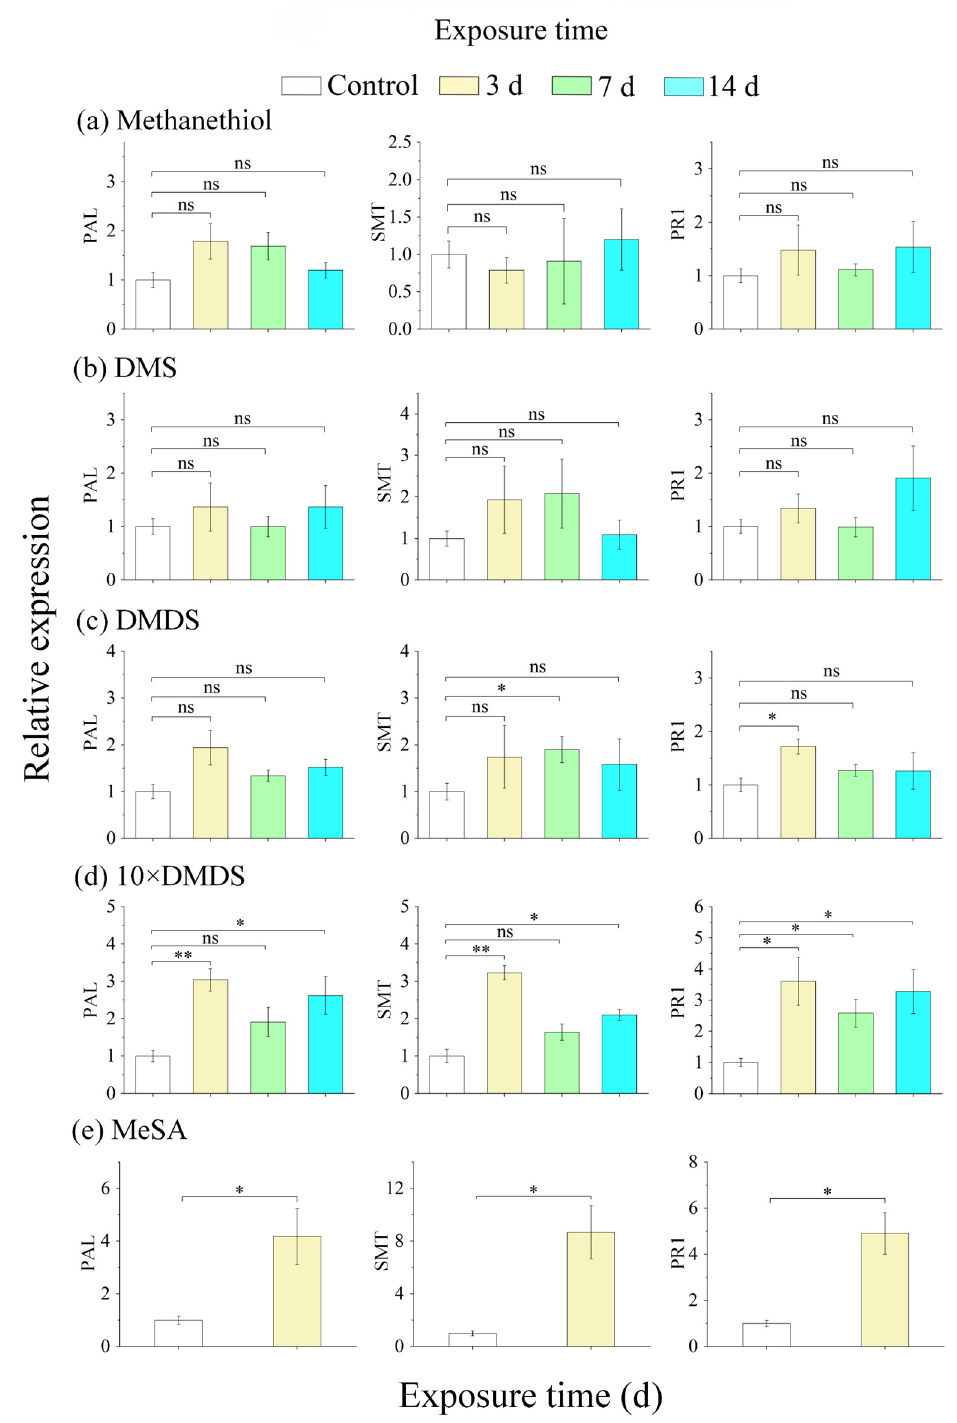
Figure 4. The expression of phenylalanine ammonia lyase (PAL), salicylate-O-methyl transferase (SMT), and pathogenesis-related (PR1) genes of orange plants after exposure to sulfur volatiles. Data are shown as means ± SE ( n = 3). Asterisks indicate significant differences between exposed and control plants, based on Student’s t -test (* p < 0.05 and ** p < 0.01); ns, no significant difference. 2.4. The Activity of Defense-Associated Enzymes and the Content of Total Polyphenol Were Enhanced in Dimethyl Disulfide-Exposed Orange Plants The PAL activity in the DMDS, 10 × DMDS, and MeSA treatments of orange leaves was 1.09-, 1.69-, and 2.04-fold higher than those in the control, respectively (Figure 5a).